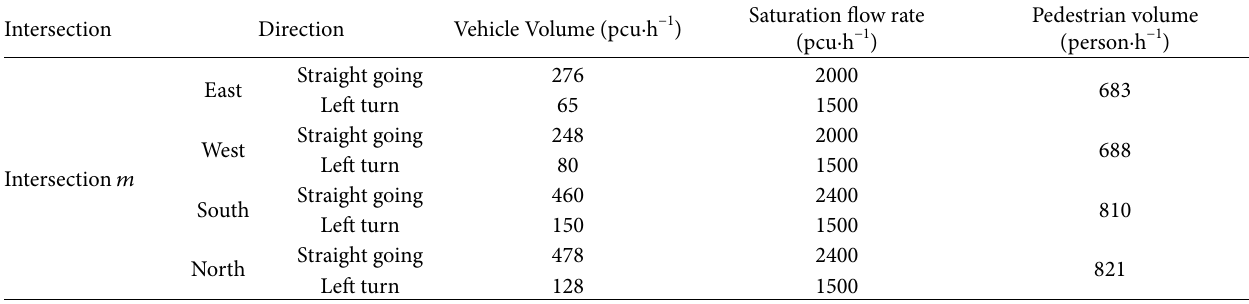
Table 3: Basic parameters of intersections during nonpeak period.